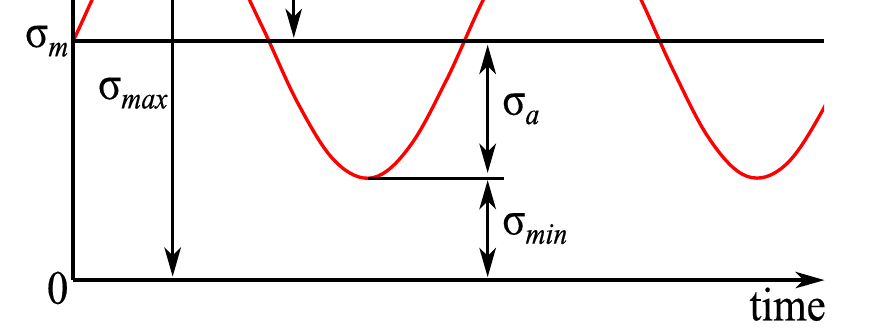
Figure 3. Fatigue cyclic load.